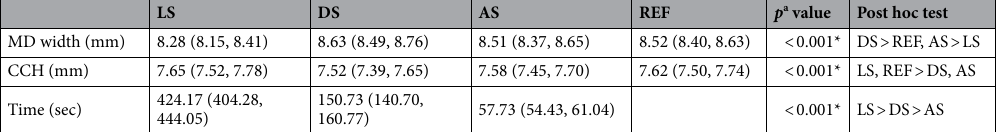
Table 4. Comparison of MD width, CCH, and segmentation time among three segmentation groups. MD width and CCH showed statistically significant differences, depending on segmentation method. The segmentation time also showed statistically significant differences in the three groups, with the AS having the least manual intervention being the shortest. Data are given as the mean (95% confidence interval). a p values were derived from Friedman test; Shapiro–Wilk’s test was employed to test the normality assumption; * p < 0.05.